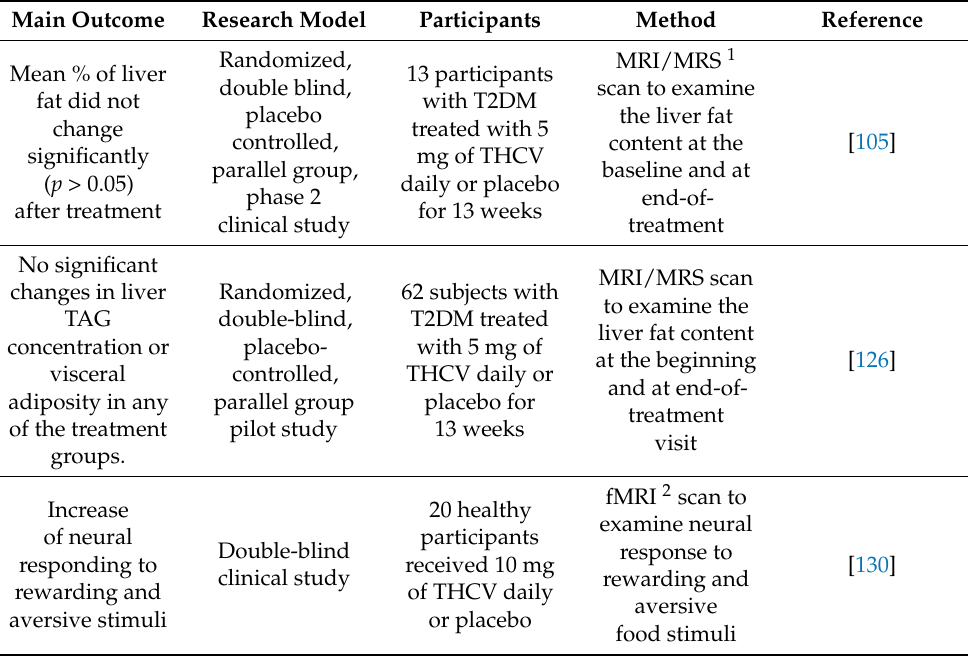
Table 6. Clinical studies analyzing the effects of THCV in NAFLD and related disorders development. Main